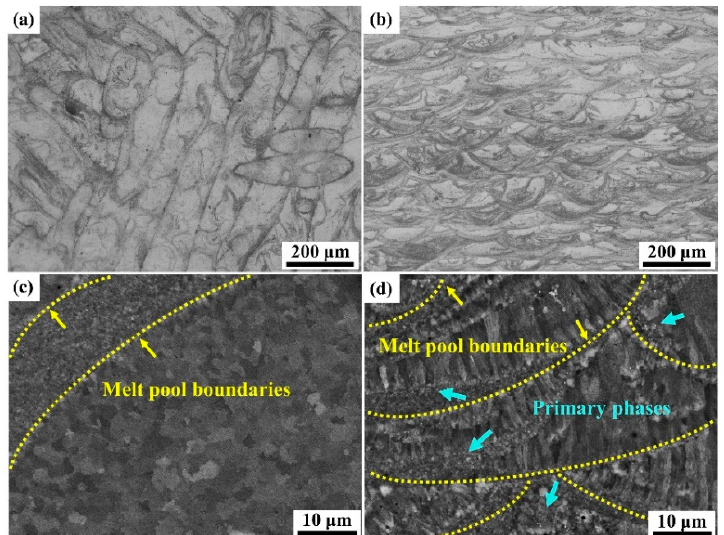
Figure 4. Micrograph of as-built sample on XY plane: ( a ) metallographic structure and ( b ) backscat- ter SEM; XZ plane: ( c ) metallographic structure and ( d ) backscatter SEM.